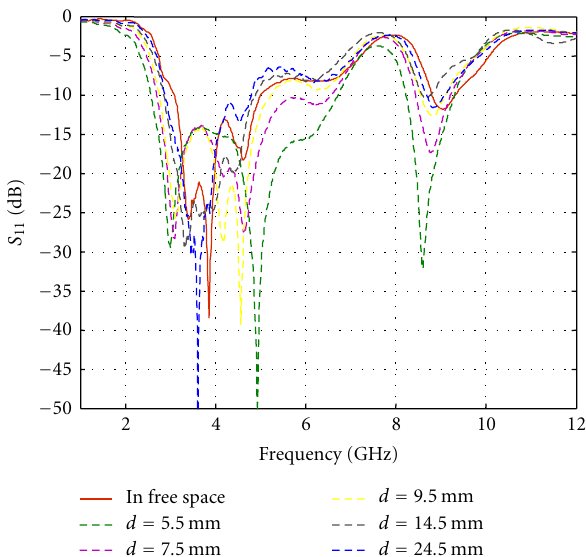
Figure 11: Measured reflection coe ffi cient of the reference MSA on a human subject for di ff erent values of the separation distance d .